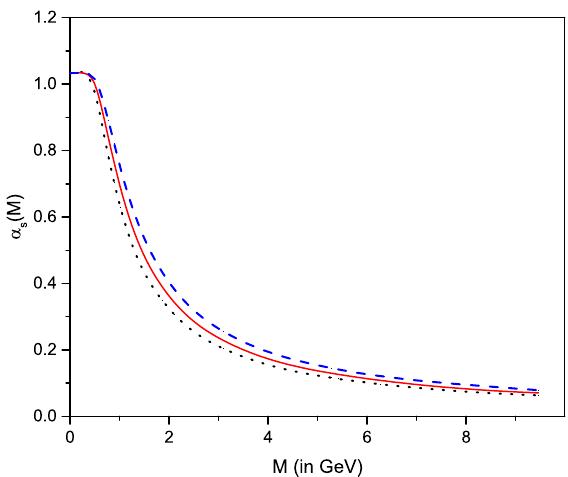
Figure 2. Mass-dependent effective strong coupling ˆ α s ( M ) for different values of confinement scale (dots for Λ = 216 MeV, solid line for Λ = 236 MeV and dashes for Λ = 256